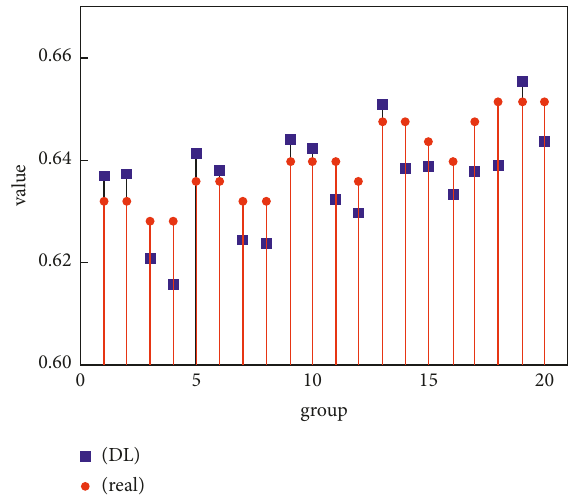
Figure 6: Distribution of predicted and actual values of video content features from self-media.